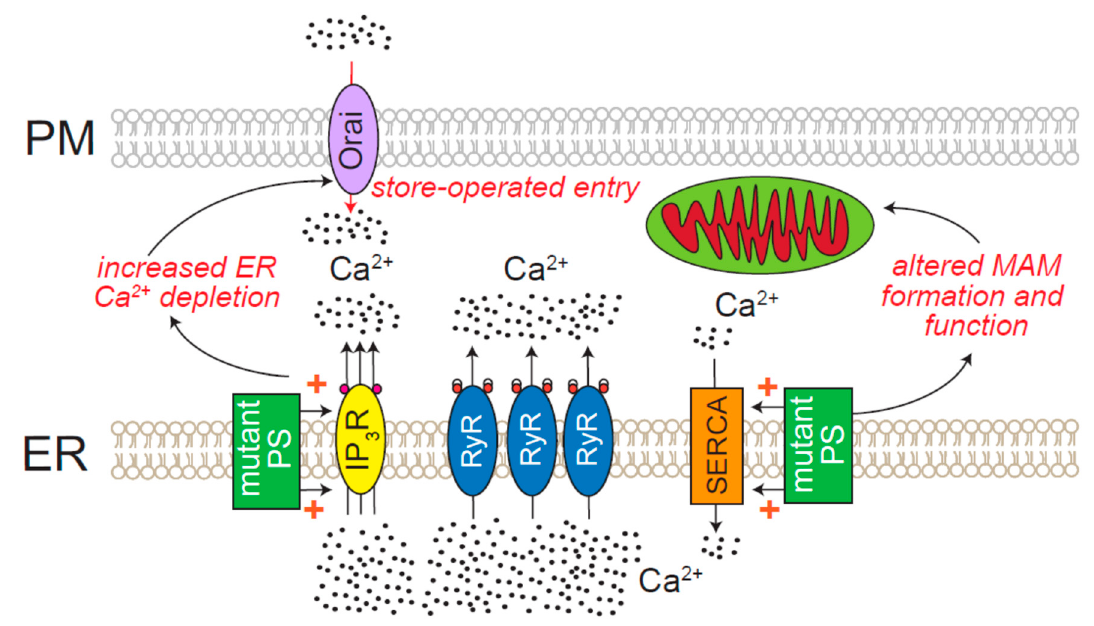
Figure 6. Mechanisms of ER Ca 2 + dyshomeostasis in Alzheimer’s disease (AD). Mutated presenilin (PS) increases ER Ca 2 + release. Various models of AD display increased expression of RyR , which can also produce elevated Ca 2 + release from the ER. Additionally, mutated PS stimulates sarco / endoplasmic reticulum Ca 2 + -ATPase (SERCA), which can fuel further release through ER Ca 2 + channels. Increased ER Ca 2 + store depletion can activate store operated Ca 2 + entry. Function of mitochondria associated membranes (MAMs) are also altered by mutated PS.